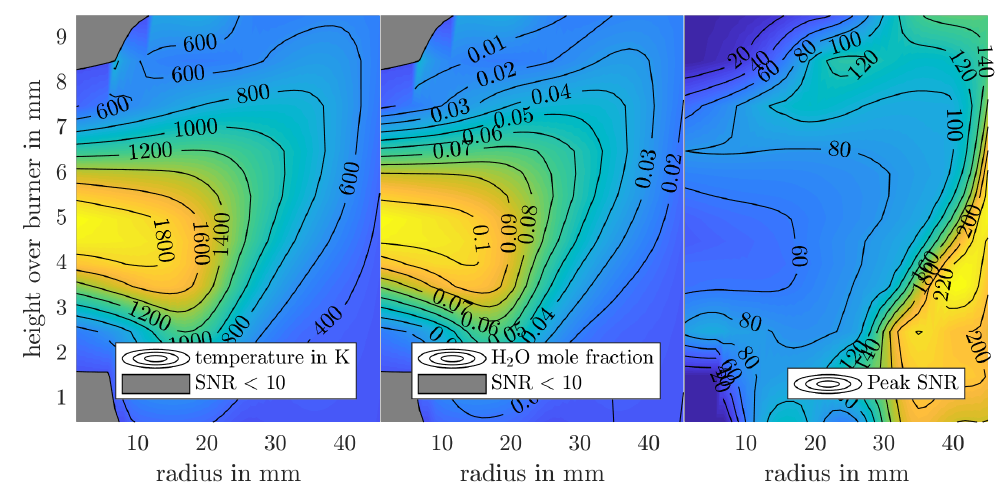
Figure 4. Temperature and water mole fraction distributions reconstructed for the Me Air operating